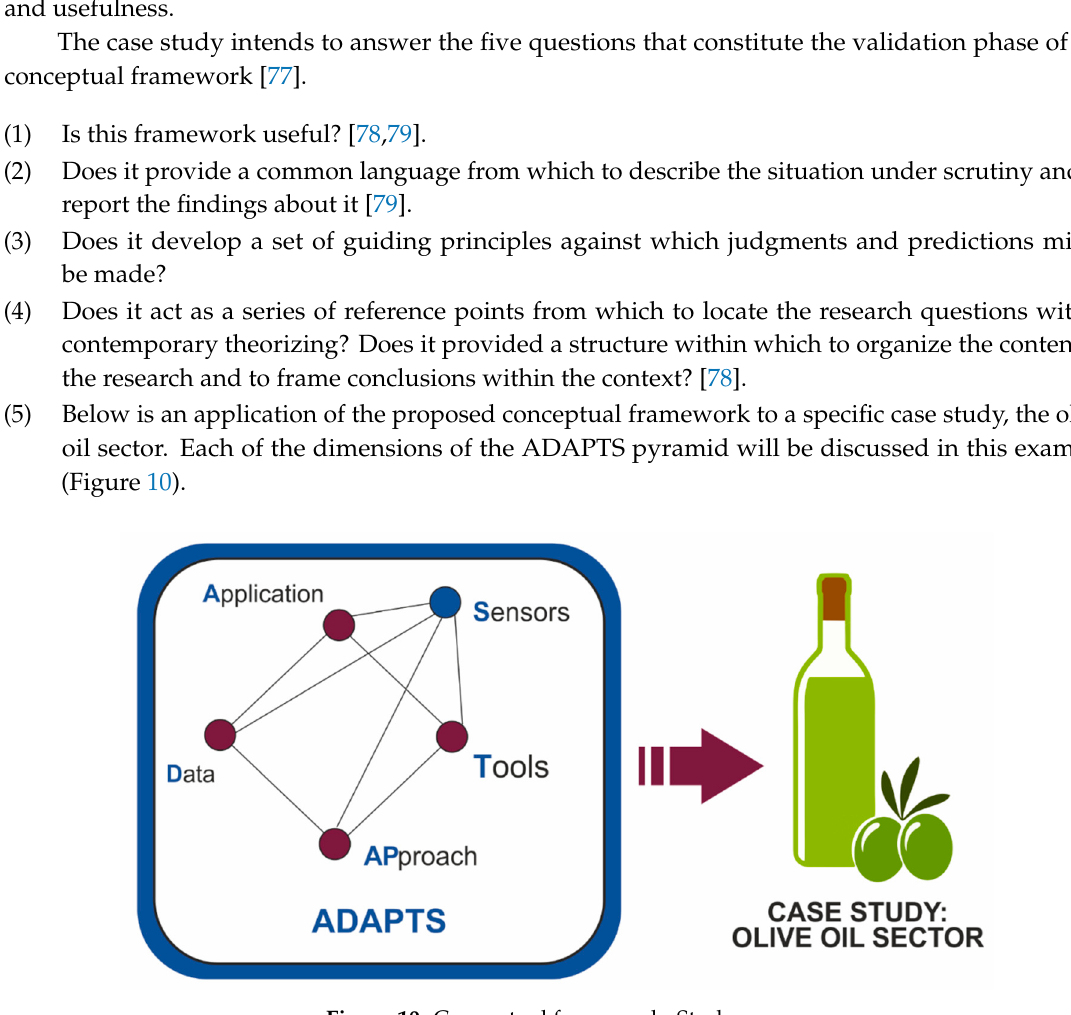
Figure 10. Conceptual framework. Study case.